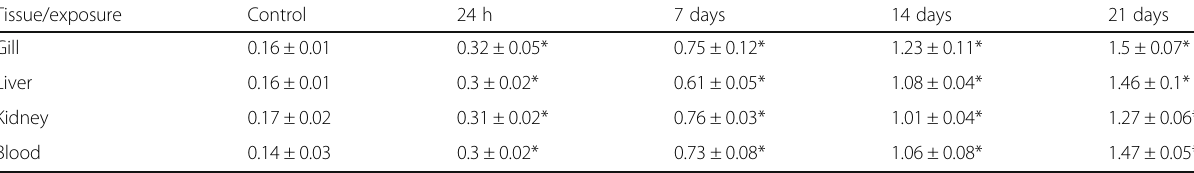
Table 6 Genetic damage index (GDI) in tissues of C. carpio on exposure to karanjin Tissue/exposure